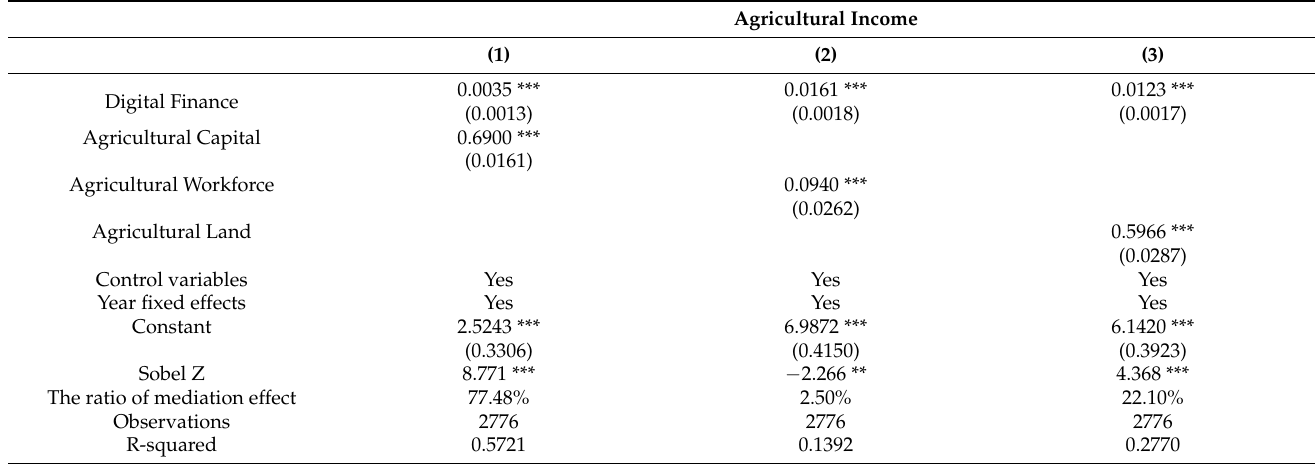
Table 7. Digital finance, agricultural production factors, and agricultural